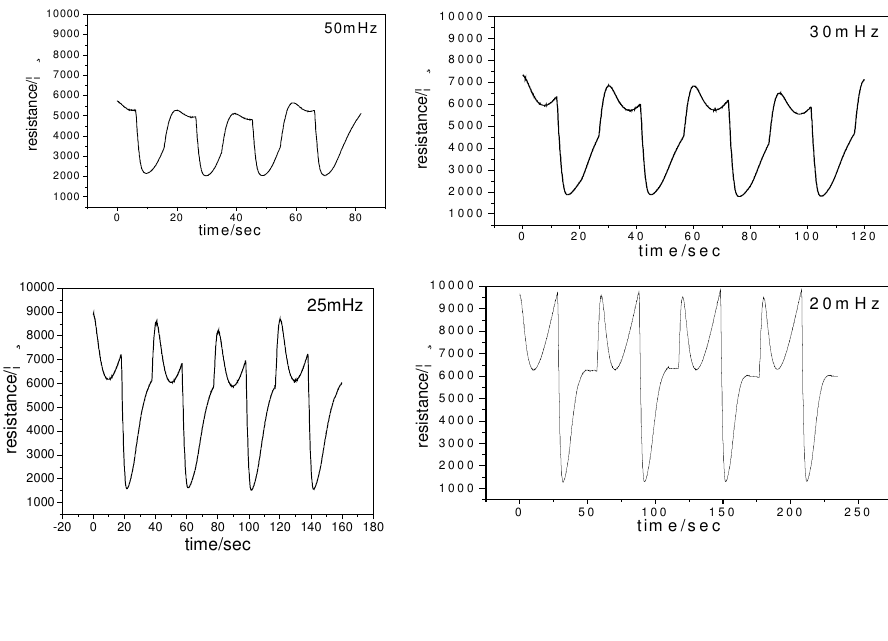
Figure 4. Effect of modulated temperature frequency on the response of 0.1ppm